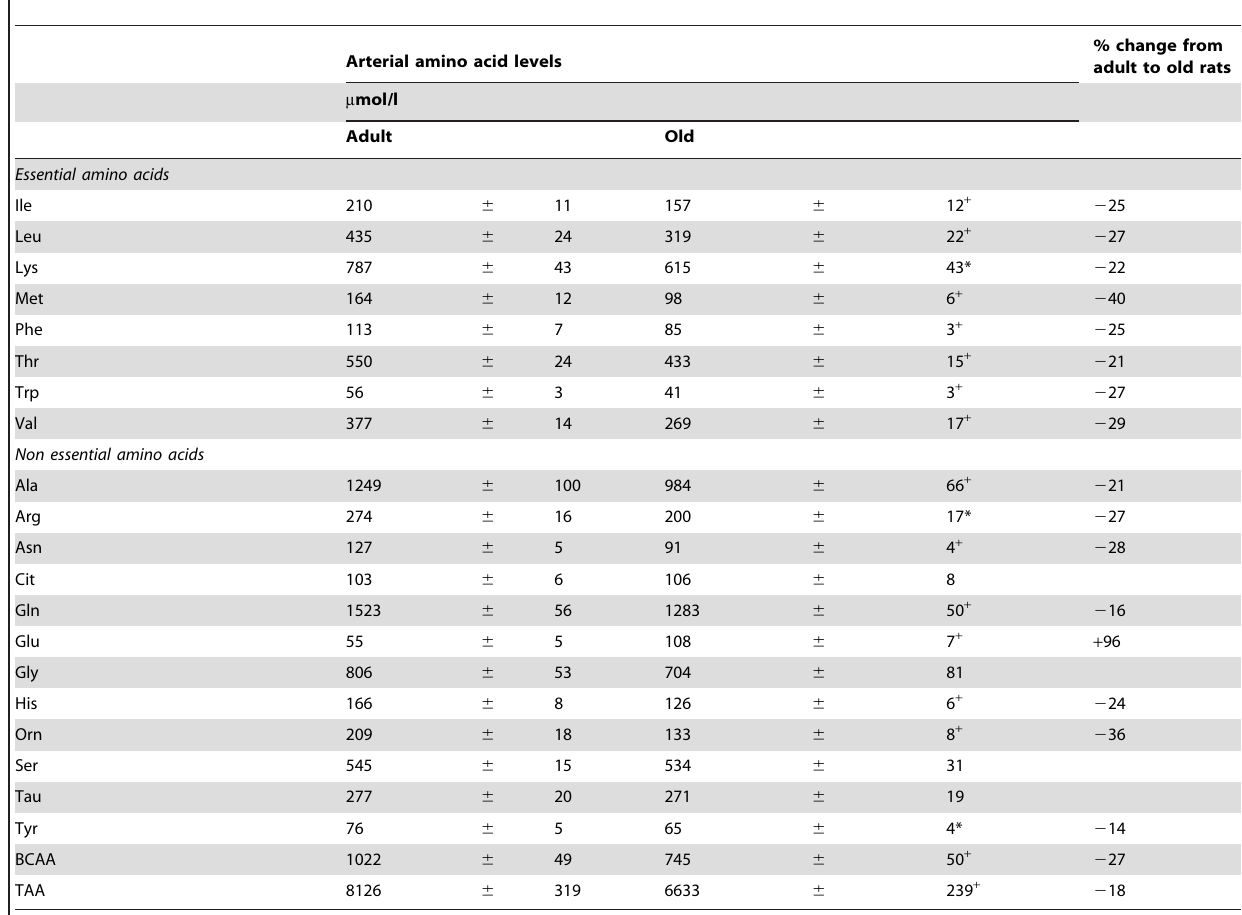
Table 4. Effect of age on arterial plasma amino acid concentrations at the fed state.